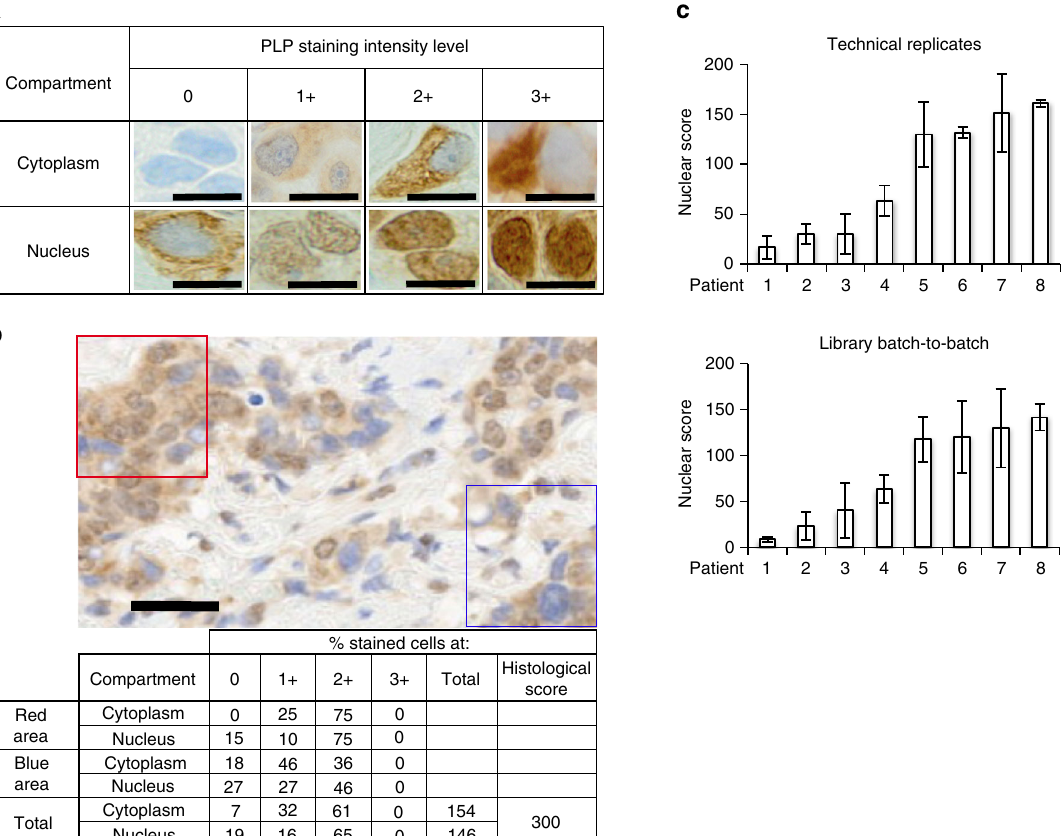
Fig. 4 Histological score calculation based on the intensities of PLP staining and reproducibility of the staining. a Representative examples of the different PLP intensity levels in the cytoplasm and the nucleus of breast cancer FFPE tissue cells, compiled from different cases and different enriched libraries (×60, 10 µ m scale bar). b Examples of the histological score calculations in two areas of the breast cancer tissue, stained with EL-NB. Note: assessment of the percentage of cancer cells with a particular staining intensity is usually performed on the entire tissue. Correspondingly, each stained case will have its unique cytoplasmic, nuclear and combined scores. Depending on the marker localization, nuclear, cytoplasmic or combined PLP scores can be informative for the differentiation of the bene fi ter from non-bene fi ter cases (×20, 20 µ m scale bar). No adjustment was applied to images from microscopy. c Reproducibility of the PLP nuclear staining and scoring using EL-NB on eight different patients between technical replicates and different batches of the library preparation. TL-NB staining of the cytoplasm was not informative for the differentiation of B and NB cases. Patients 1 – 4 were selected as examples of relatively weak intensity staining, patients 5 – 8 are examples of relatively strong intensity staining (error bars are s.d. from three